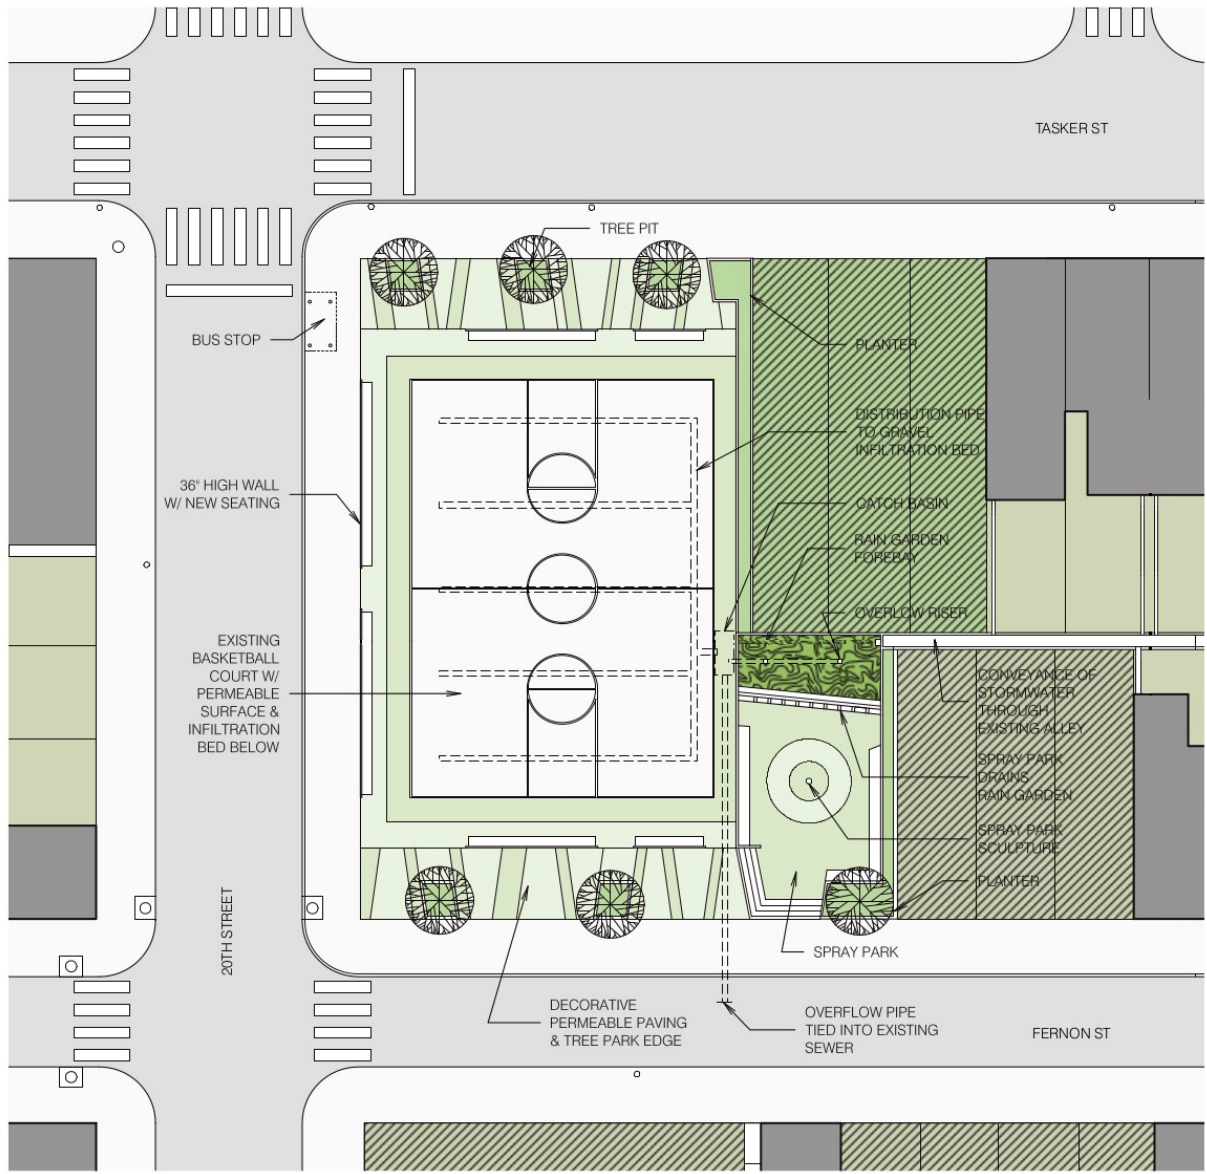
Figure 7. Model 2—Plan view of block-end parcel detail, including a central rain garden and permeable ball